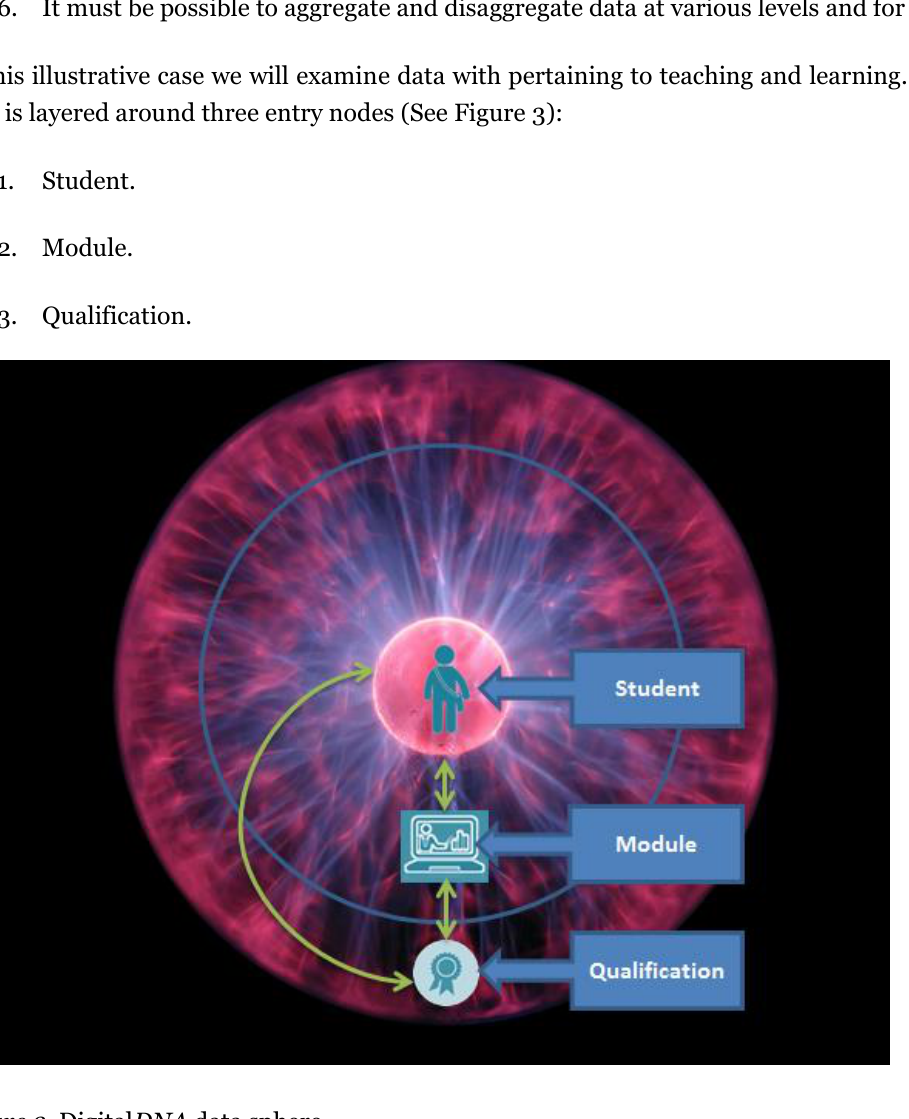
Figure 3. Digital DNA data